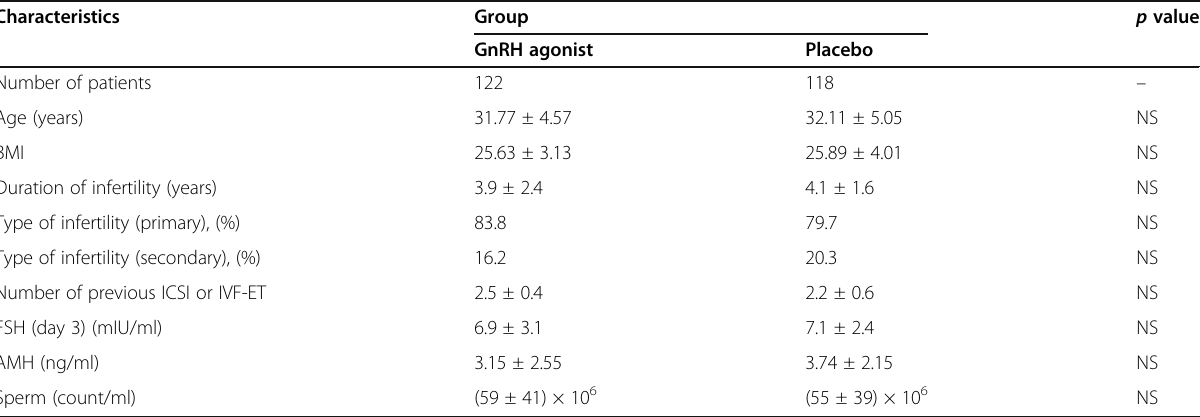
Table 2 Demographic and clinical characteristics of the studied groups Characteristics